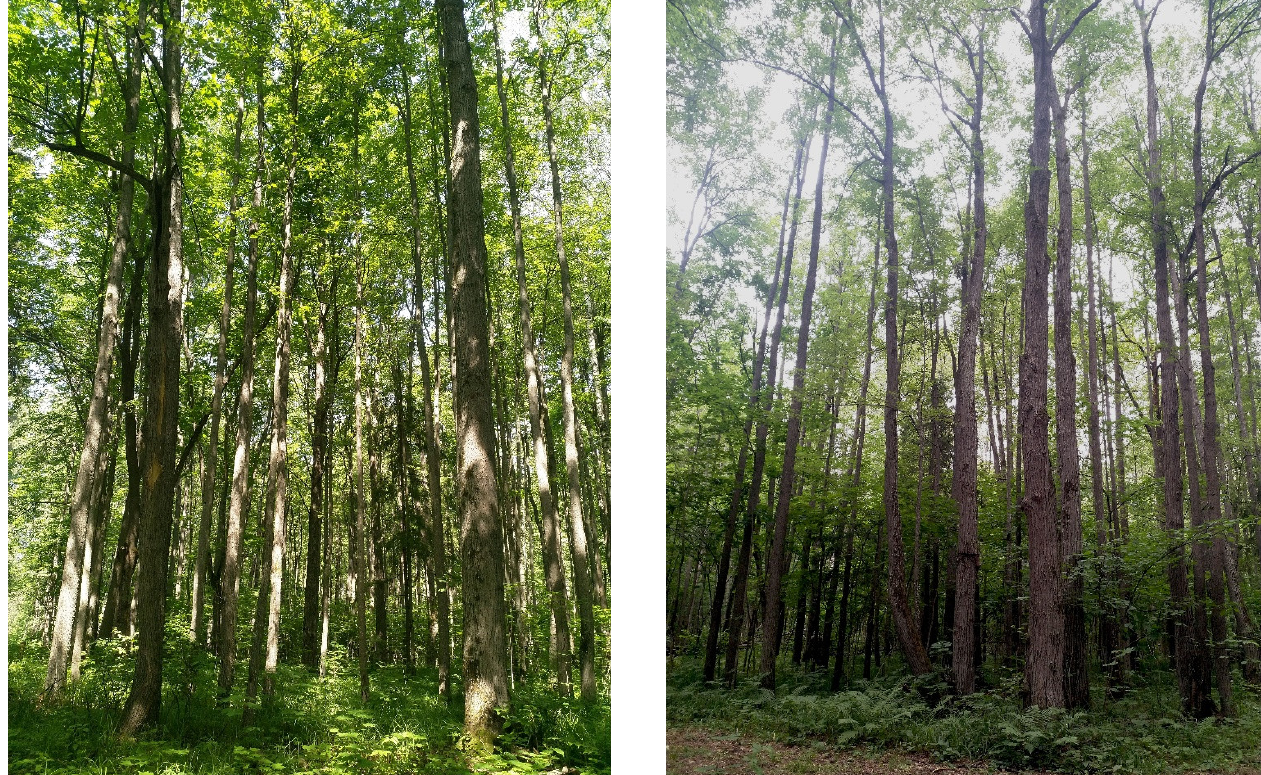
Figure 2. Research sites on the territory of the Mordovia State Nature Reserve. On the left is number 3, on the right is number 5 (the site numbers are shown in Figure 1).